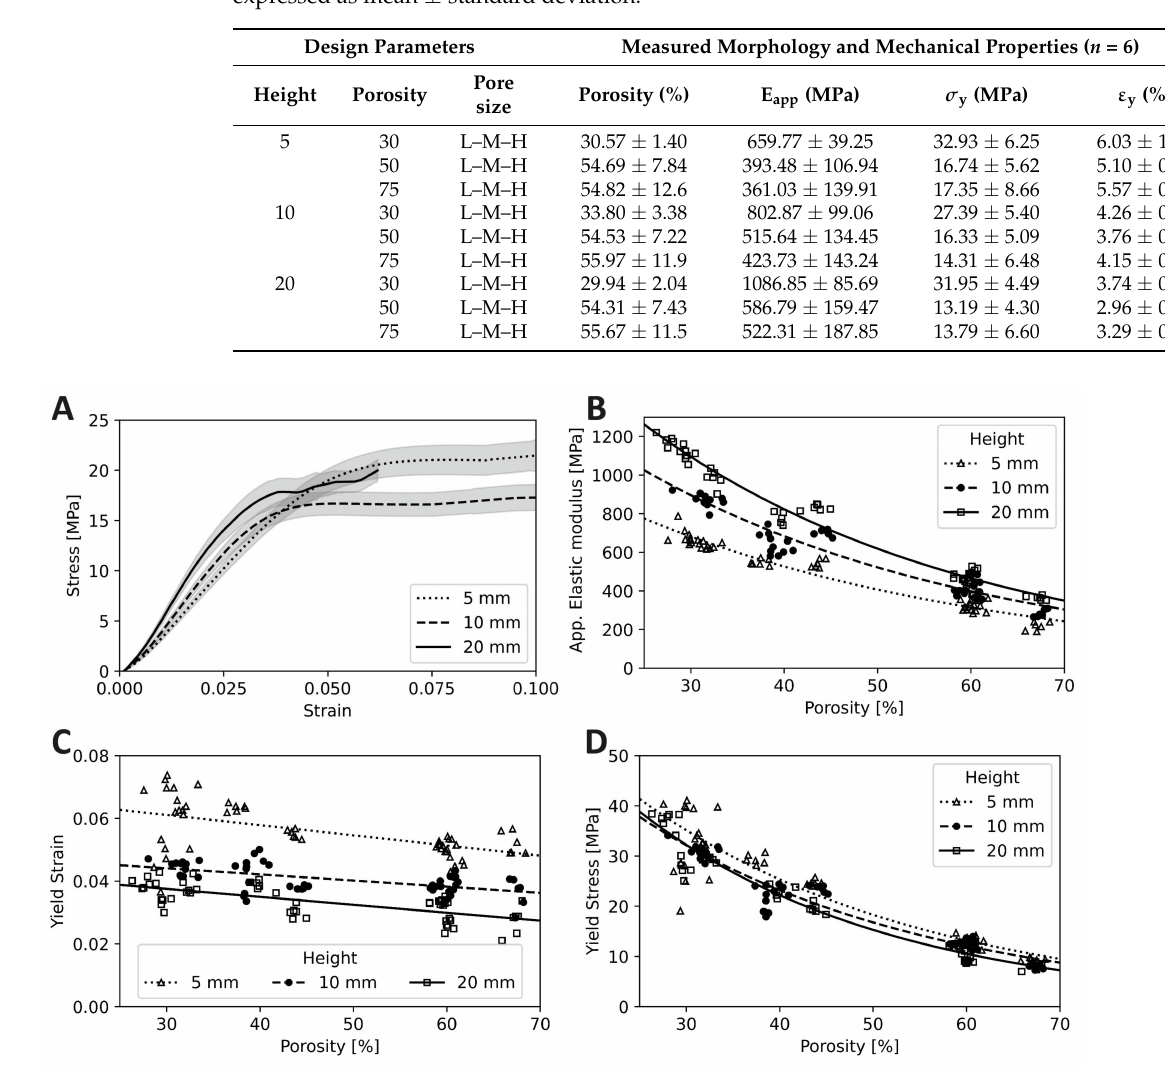
Table 3. Design parameters and specimen measured morphology and mechanical properties. De-